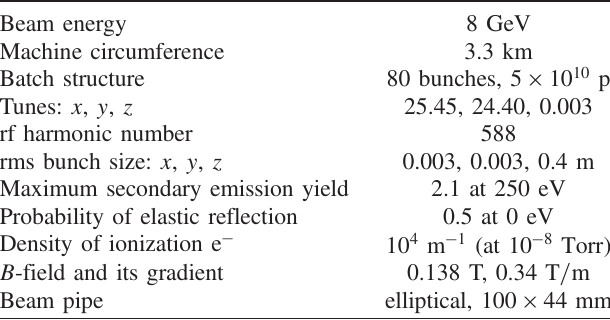
TABLE I. Recycler parameters for simulation in PEI